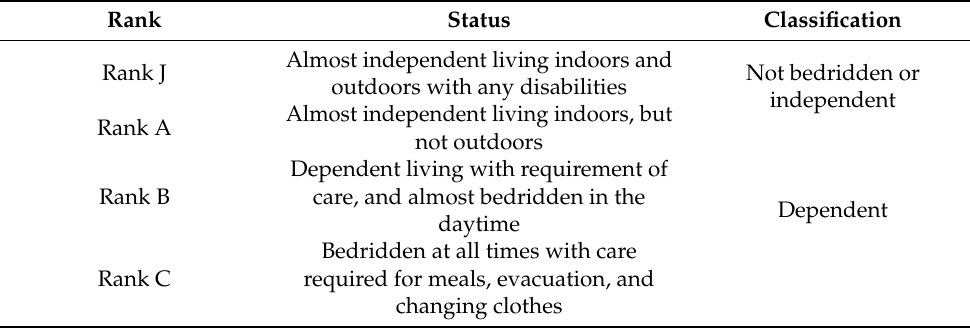
Table 1. Rank for activity of daily